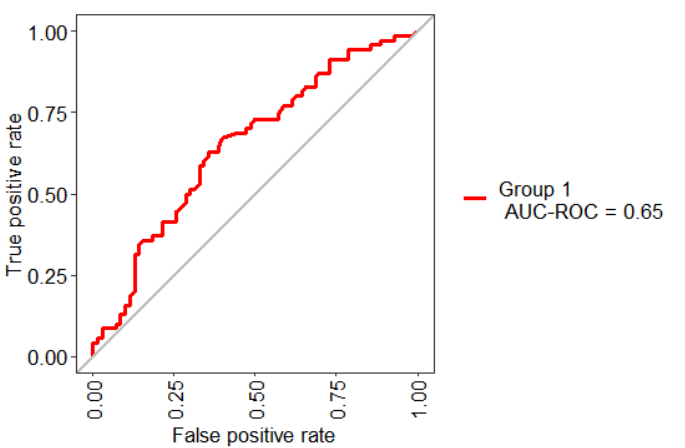
Figure 2. Receiving operating characteristic (ROC) curve obtained for the model based on the total set of features.